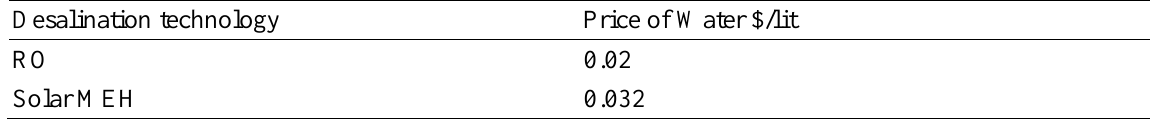
Table 8. Proposed Prices for Guaranteed Purchase of Potable Water